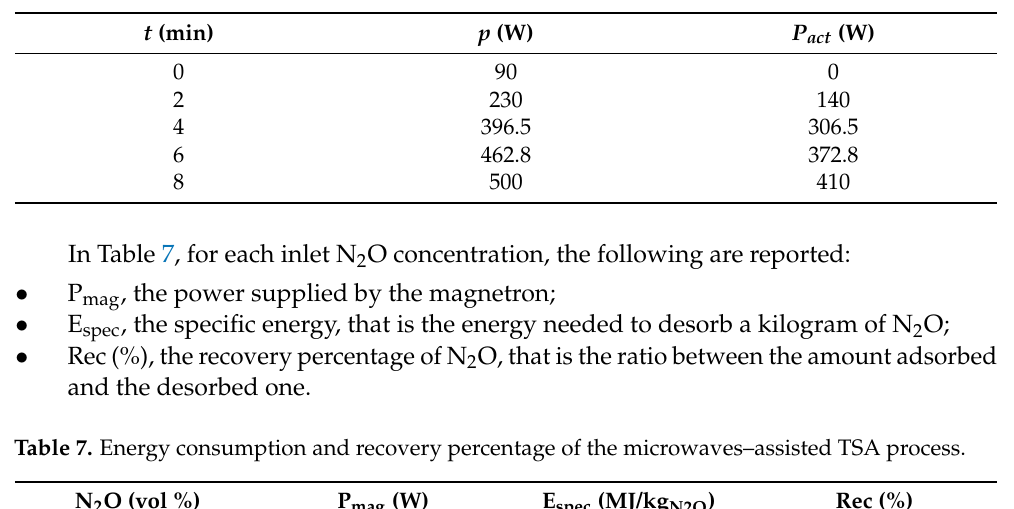
Table 6. Power trend in the initial transient phase.